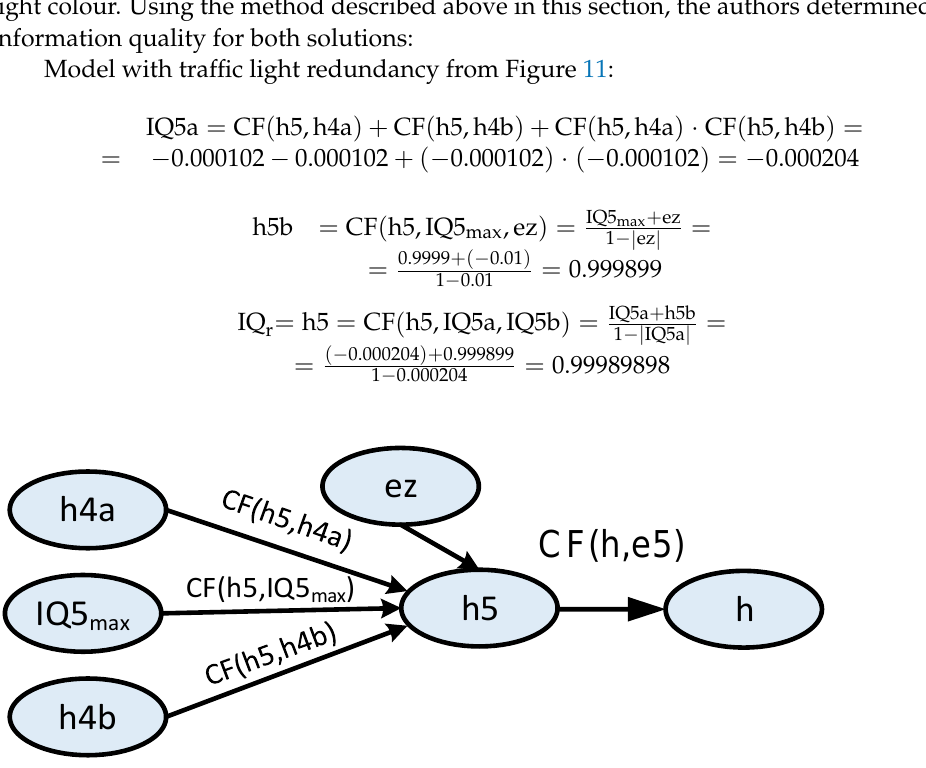
Figure 11. IQ model of the fifth information status for the example with double traffic lights and impact of the ez interpretation-interfering element considered (the authors’ own study).